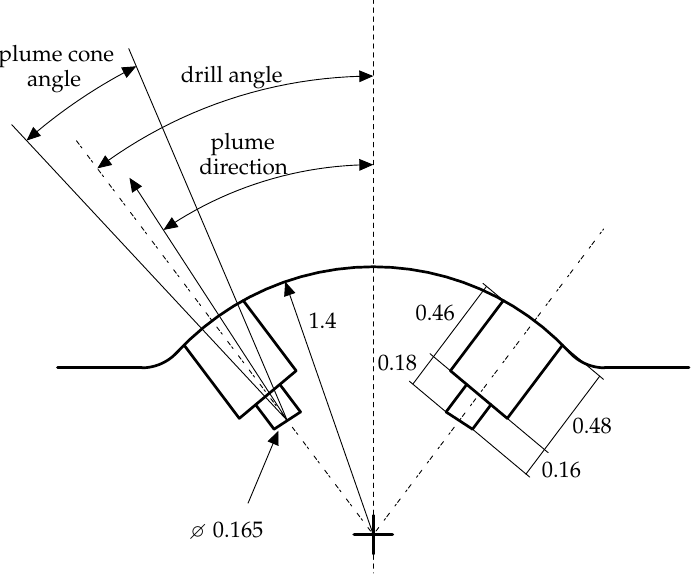
Figure 1. Specification of the “ Spray G ” nozzle geometry. The dimensions are expressed in millimeters.